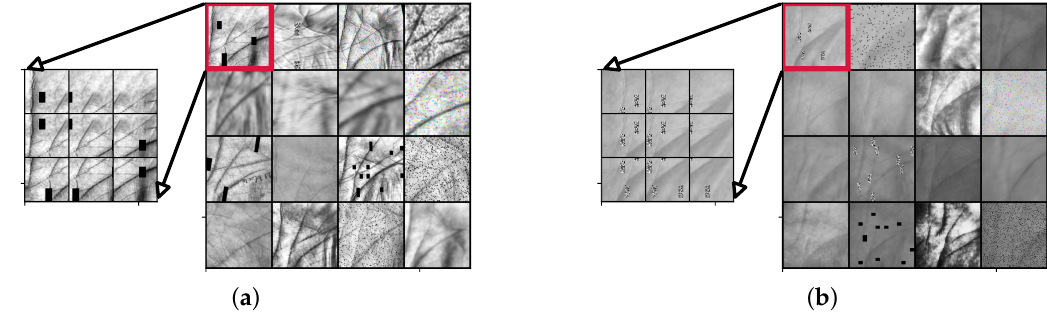
Figure 8. Illustration of different data augmentations as well as the patch decomposition procedure for sample images from ( a ) the IITD dataset and ( b ) the CASIA